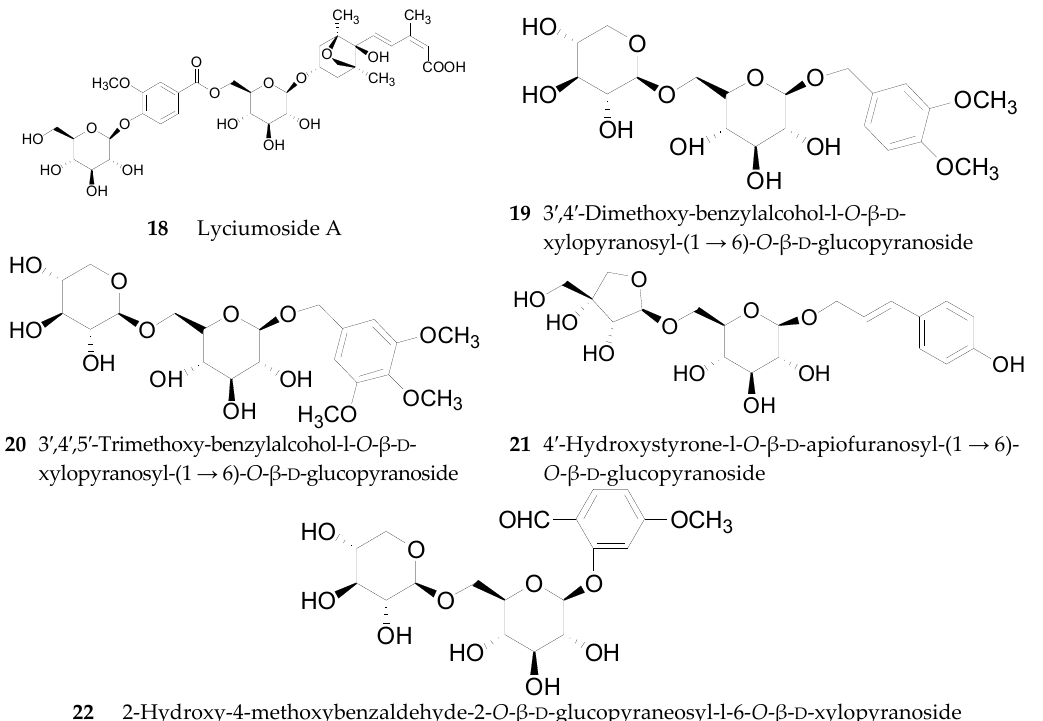
Figure 2. Chemical structures of compounds 18 – 22 .